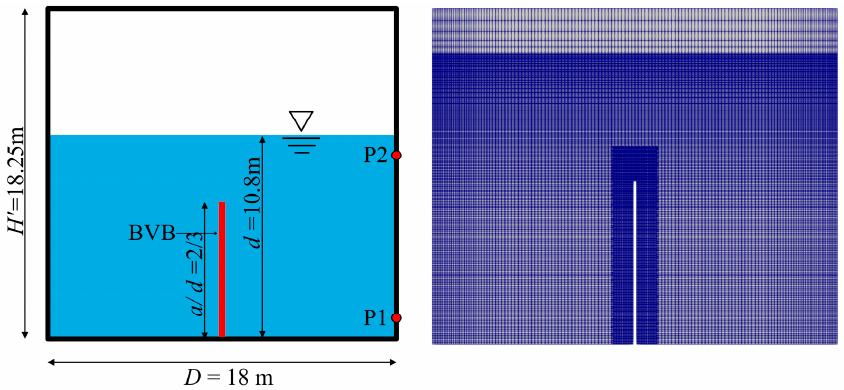
Figure 13. Location of the damping baffle in the water tank and mesh geometry.